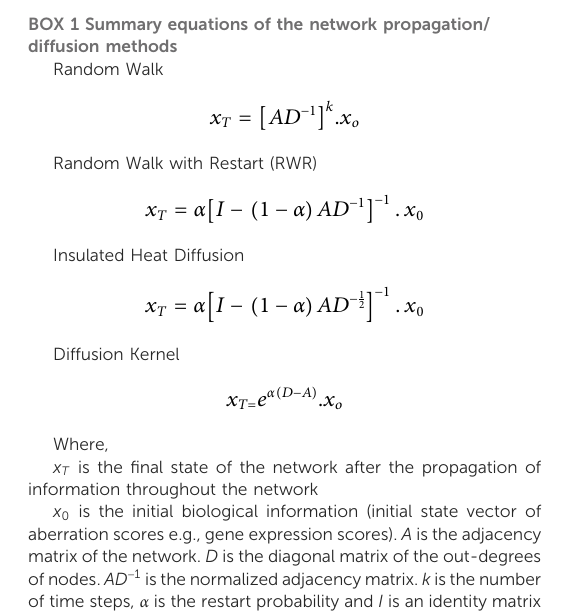
BOX 1 Summary equations of the network propagation/ diffusion methods Random